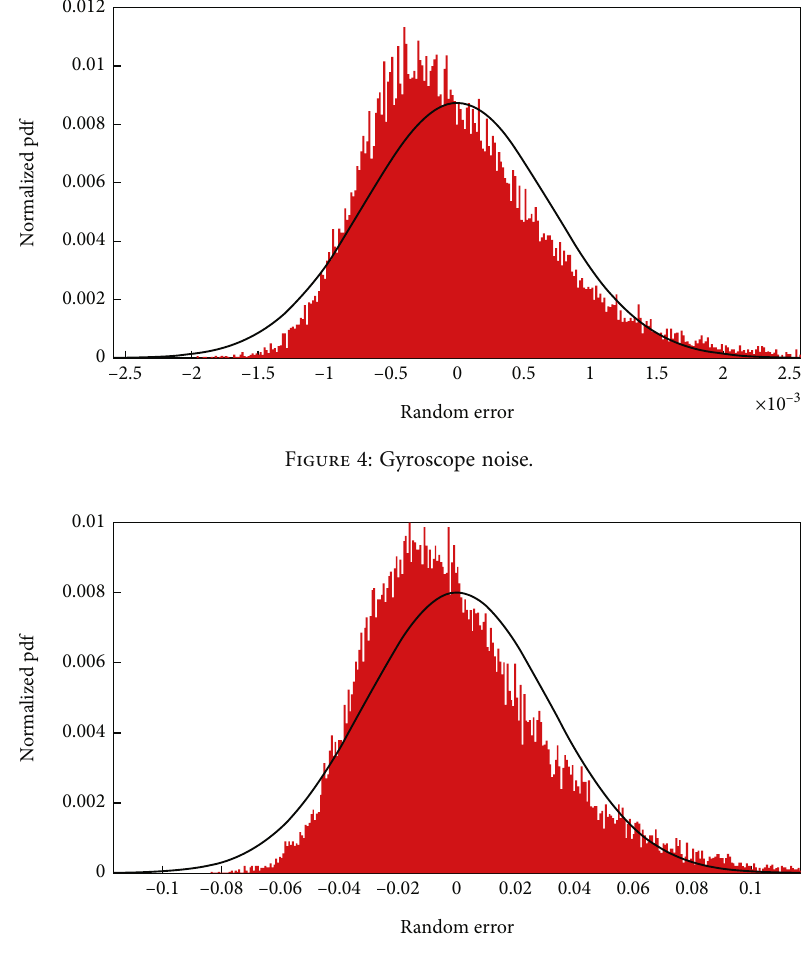
Figure 5: Accelerator noise.